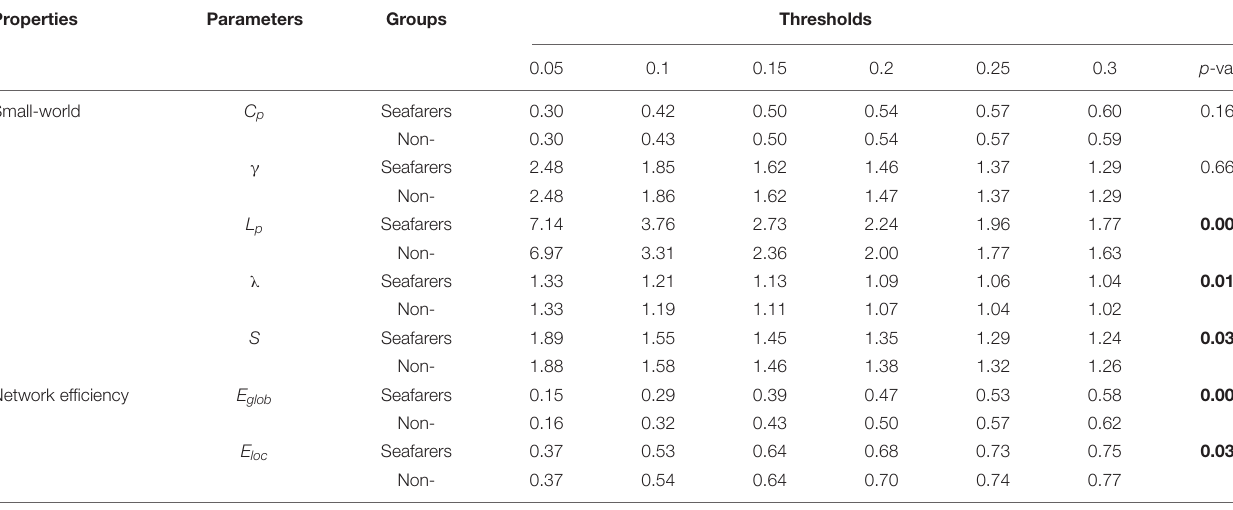
TABLE 8 | The mean of all network parameters for seafarers and non-seafarers at Len = 80 TRs are presented, as well as the results of two-way ANOVA ( p -value). Properties